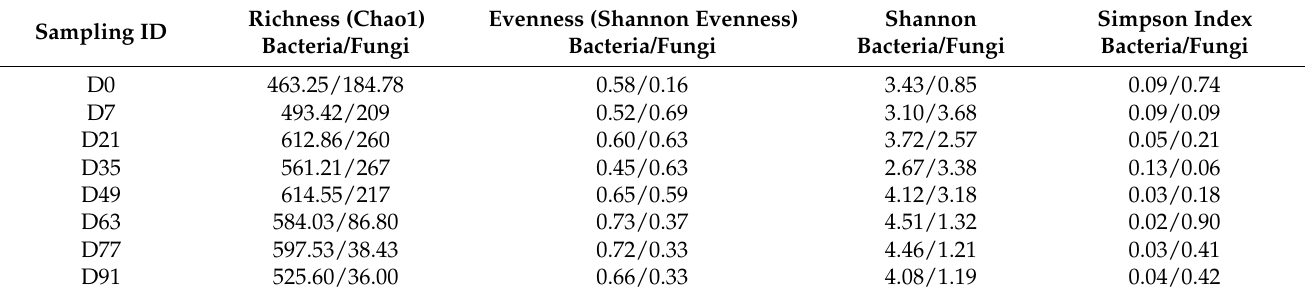
Table 3. The bacteria/fungi diversity of samples during the composting